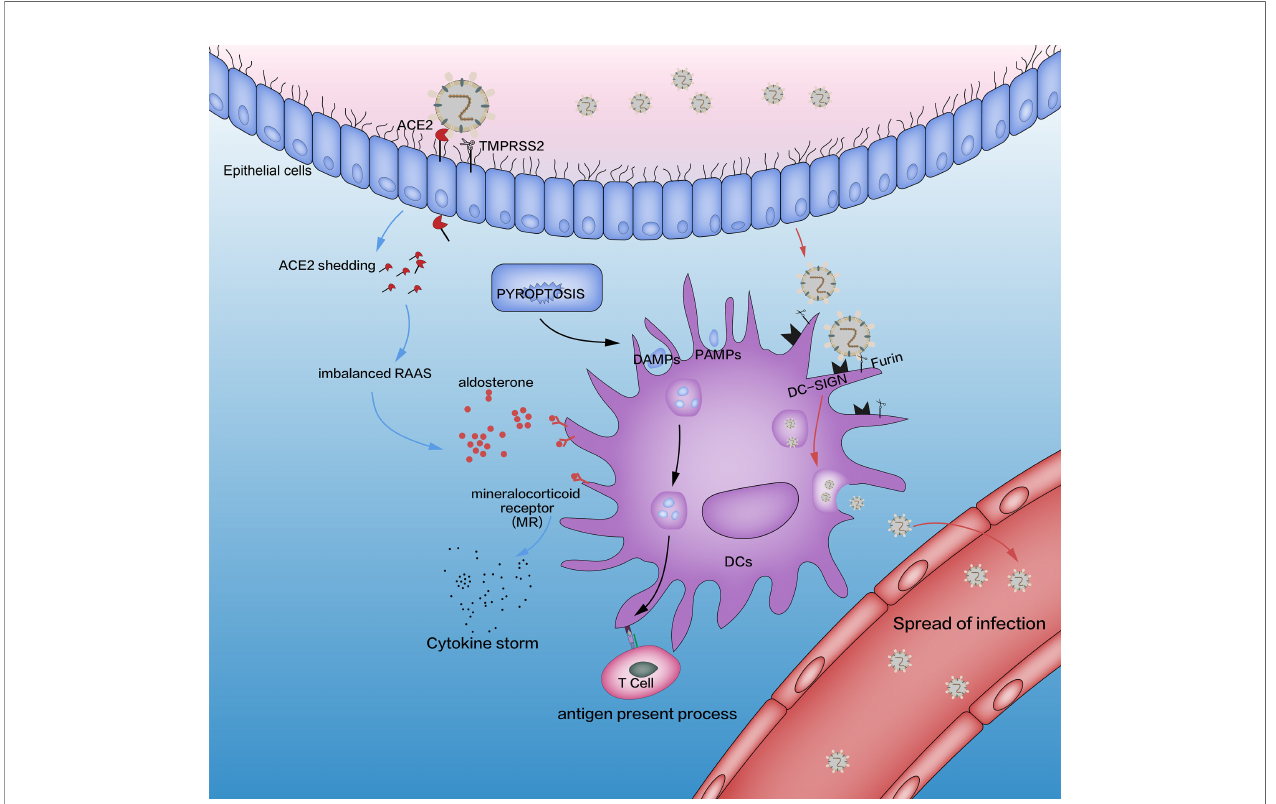
FIGURE 1 | Interaction between SARS-CoV-2 and DCs (schematic). The three pathways affected by SARS-CoV-2 are pyroptosis (black lines), imbalanced RAAS (blue lines), and DC-SIGN (red lines). The adaptive immune system is induced by pyroptosis, which is activated by SARS-CoV-2. In addition, SARS-CoV-2 combines with the ACE2 receptor through its spike protein (S), which is activated by TMPRSS2. This process causes an imbalance in the RAAS through the shedding of ACE2 and releases excessive amounts of aldosterone, which promotes the release of proin fl ammatory cytokines in DCs through MRs. SARS-CoV-2 impacts DCs directly by DC- SIGN, a receptor which has critical roles in the recognition of viruses (e.g., HIV, Ebola, dengue, cytomegalovirus) and other pathogens (e.g., Leishmania species, Candida albicans , Mycobacterium tuberculosis , Streptococcus pneumoniae , Aspergillus fumigatus ). Although SARS-CoV-2 replication in lung cells is well-documented, a similar process has not been con fi rmed in alveolar DCs. Some researchers have suggested such a replication based on triggering aberrant production of proin fl ammatory cytokines/chemokines and inducing the spread of SARS-CoV-2 infection, as is the case with SARS-CoV and MERS-CoV, but other scholars have ruled out SARS-CoV replication in human DCs. RAAS, renin – angiotensin – aldosterone system; DCs, dendritic cells; TMPRSS2, transmembrane serine protease 2; MRs, mineralocorticoid receptors; DC-SIGN, dendritic cell-speci fi c intercellular adhesion molecule 3-grabbing